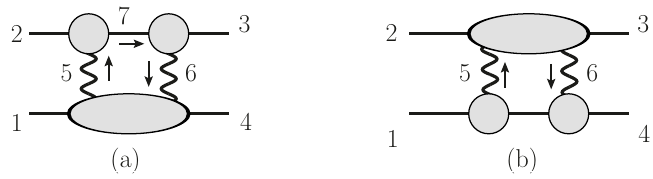
Figure 7 . The two generalized unitarity cuts for extracting the conservative two-body potential at 2PM order. The blobs represent tree amplitudes and exposed lines are all on shell. Straight lines represent massive scalars and the wiggly lines are either gluons or gravitons, depending on whether we are considering a gauge theory or a gravity